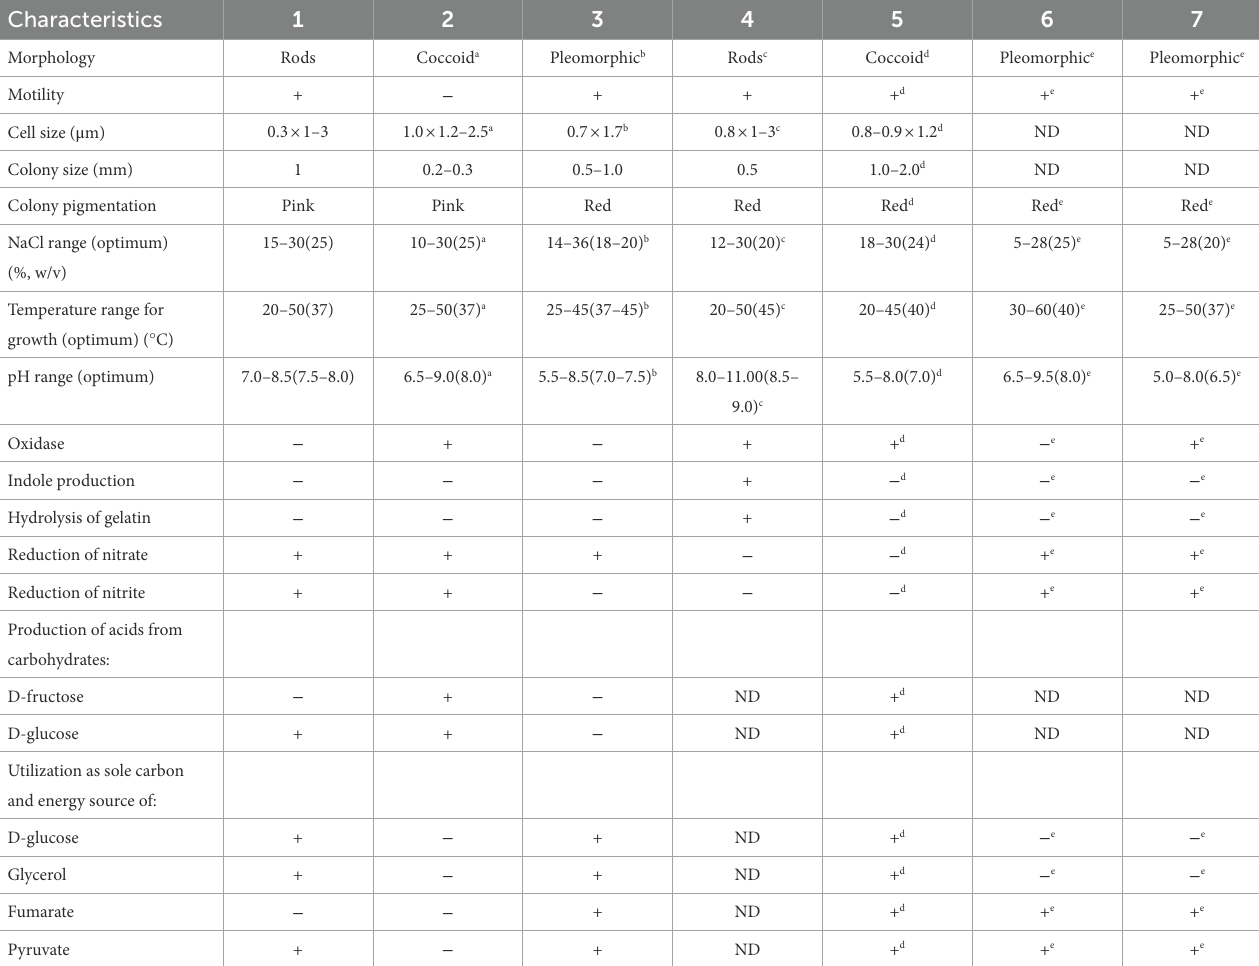
TABLE 2 Differential characteristics of Natronomonas aquatica F2-12 T , Natronomonas salsuginis F20-122 T , Natronomonas moolapensis CECT 7526 T , Natronomonas pharaonis DSM 2160 T , Natronomonas gomsonensis SA3 T , Natronomonas halophila C90 T , and Natronomonas salina YPL13 T .